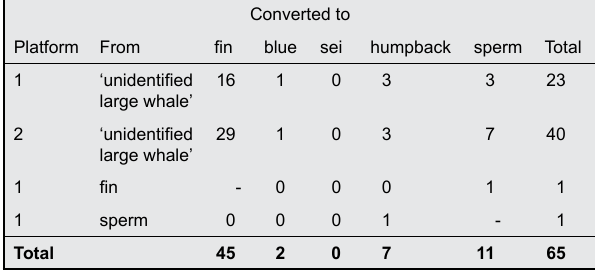
Table 5. Species identification and reclassifications based on judged duplicate sightings and additional information from the two platforms, data 1996-2001.